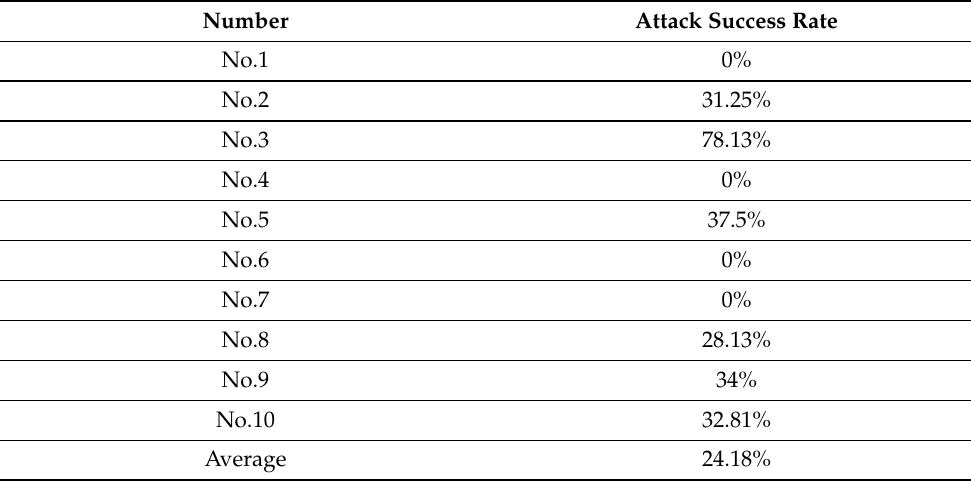
Table 6. Digital Dodging Attack in 10 people’s database.